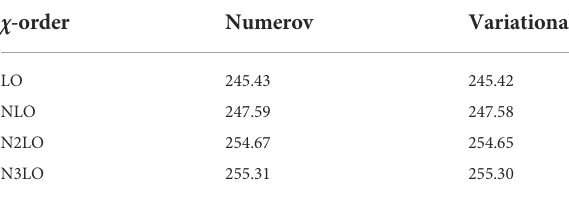
TABLE 3 Total doublet capture rate in the 1 S 0 nn channel, Γ D ( 1 S 0 ) in s − 1 , calculated using the four Norfolk potentials NVIa, NVIb, NVIIa, and NVIIb, and consistent currents, at the various chiral orders. We also report the uncertainty due to the truncation of the chiral expansion in the current for each order. The axial charge radius is taken to be r 2 A (cid:2) 0 . 46 fm 2 , and the variational method is applied to calculate the deuteron and the nn scattering wave